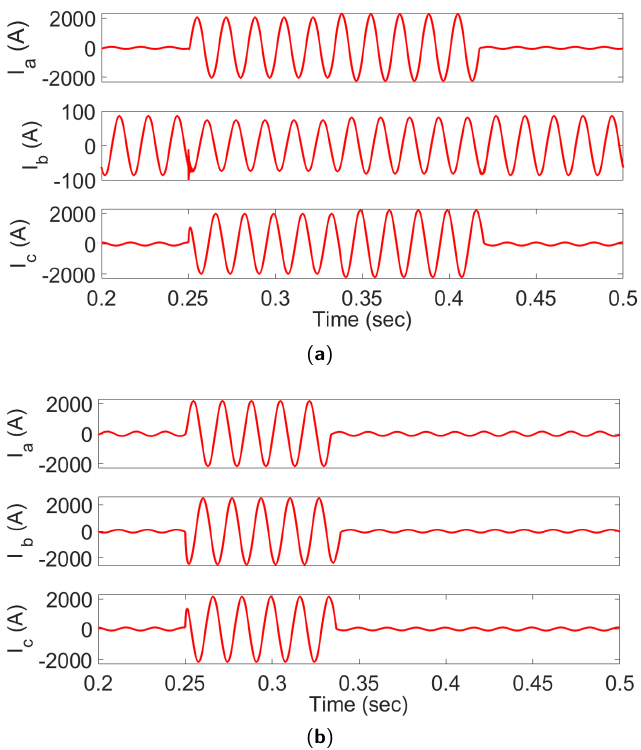
Figure 6. Per phase current levels between zone 1 and zone 2 i-e sensor 2 ( a ), per phase current levels between zone 3 and zone 4 i-e sensor 4 ( b ) for case